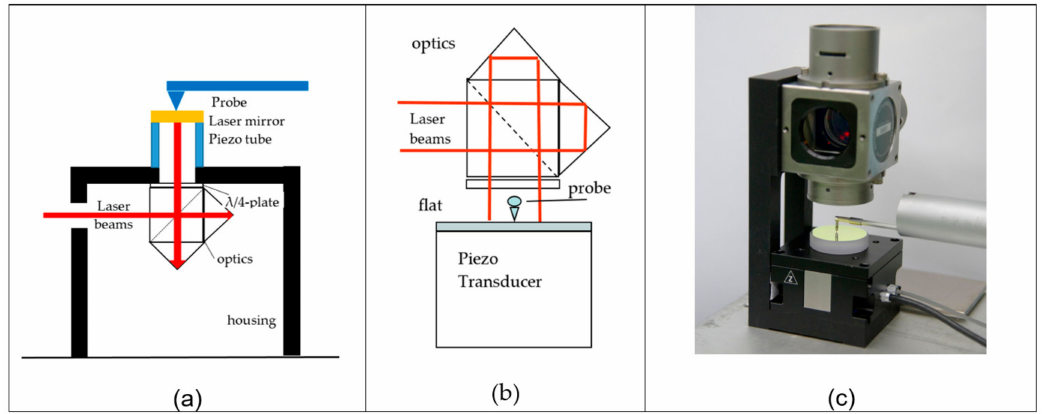
Figure 4. Dynamic calibration set-ups based on a laser interferometers as a reference sensor. A laser mirror is moved by ( a ) piezo transducer and measured simultaneously by a probe and the laser interferometer. ( b ) The same principle as ( a ). however the mirror movement is measured from the same side. ( c ) Picture of a set-up as sketched in ( b